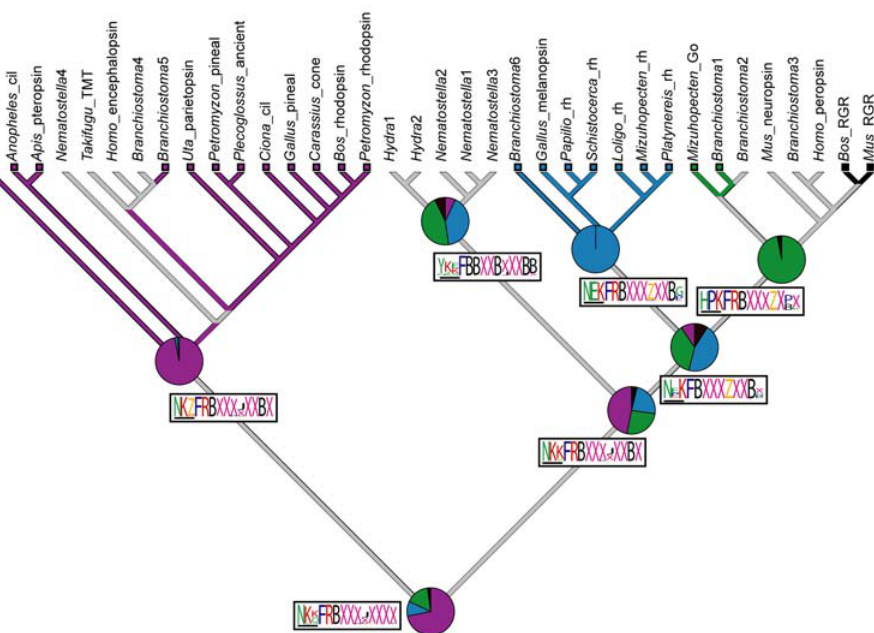
Figure 6. Ancestral state reconstruction of G protein-binding interactions for each metazoan opsin-mediated phototransduction cascade obtained by simulated mutational mapping [ 64 ] (see methods). For each class of opsin, the P value of the reconstructed ancestral G a interactions is represented in pie graphs. Ancestral G protein interactions in phototransduction cascades mediated by ciliary, rhabdomeric and G o opsins can be significantly resolved (P . 0.95) but the ancestral states of the rhabdomeric + G o , and cnidops clades are equivocal. ML state reconstructions shown for each node as colored branches. Red, G i/t ; Blue, G q ; Green, G o ; Black, no G protein interaction (as is the case for RGR/Retinochrome opsins); Grey, equivocal reconstruction from ML. Reconstructed ancestral amino acid motifs of the 4th cytoplasmic loop region of opsin are shown along branches in logos. Maximum vertical height scales to P =1.0. We obtained clear reconstructed states for most of the residues in a conserved tripeptide motif (residues 310, 311 and 312, horizontal bar) for the ciliary, rhabdomeric and G o /RGR nodes. For the most part, the remainder of the residues in can be unequivocally reconstructed to the level of Dayhoff classes. B=HRK, X=LIVM, J=GATSP, Z=DENQ.